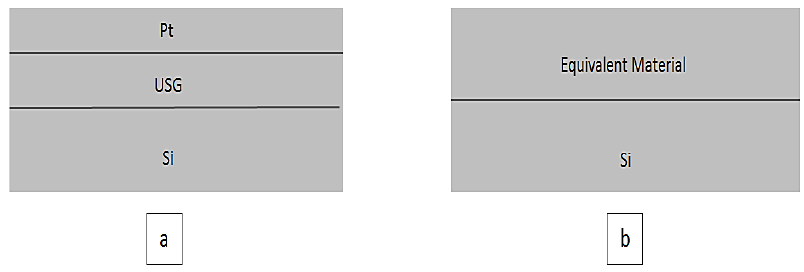
Figure 4. ( a ) Heterogeneous model and ( b ) equivalent homogenized model.